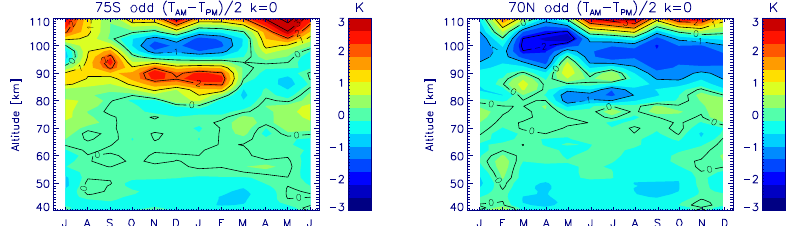
Figure 4. Time series of the vertical distribution of average (2007–2012) (cid:49)T/ 2 monthly zonal means ( | n odd − s | = 0 mode) at high latitudes (75 ◦ S, left; 75 ◦ N,